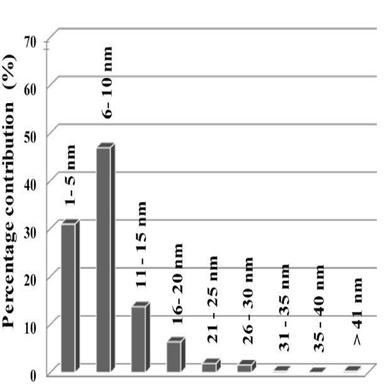
TEM image and histogram of nanoparticles for a) Red-C-Fe4.0HAlBEA and b) Red-C-Fe4.0SiBEA after calcination at 500 ◦C for 3 h and reduction at 900 ◦C.